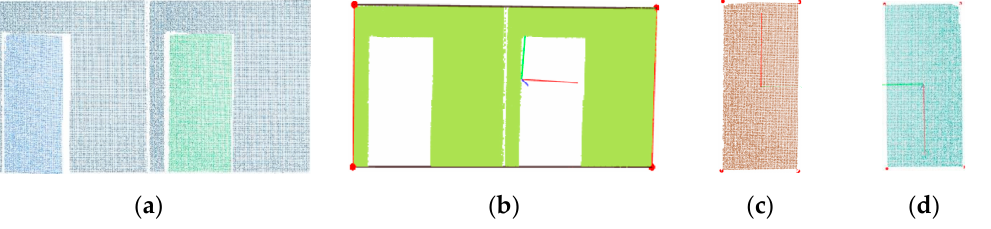
Figure 10. Corner points of the wall with multiple candidate doors. ( a ) Original scene; ( b ) plane1; ( c ) plane2; ( d ) plane3. Table 1. Plane category analysis.